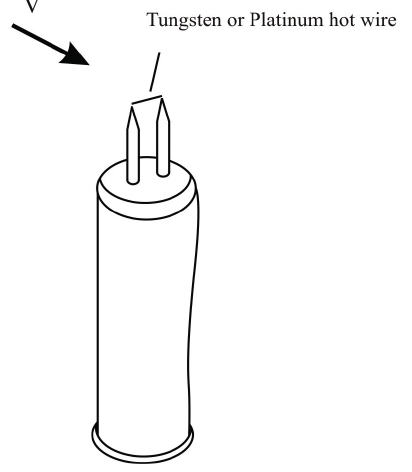
Figure 3. Typical thermo-anemometer diagram [10].